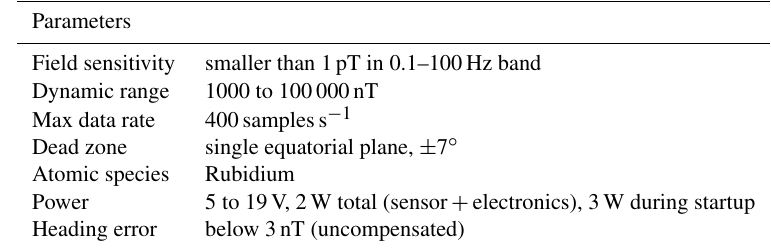
Table 2. Specifications of QuSpin total field magnetometers (QTFM).